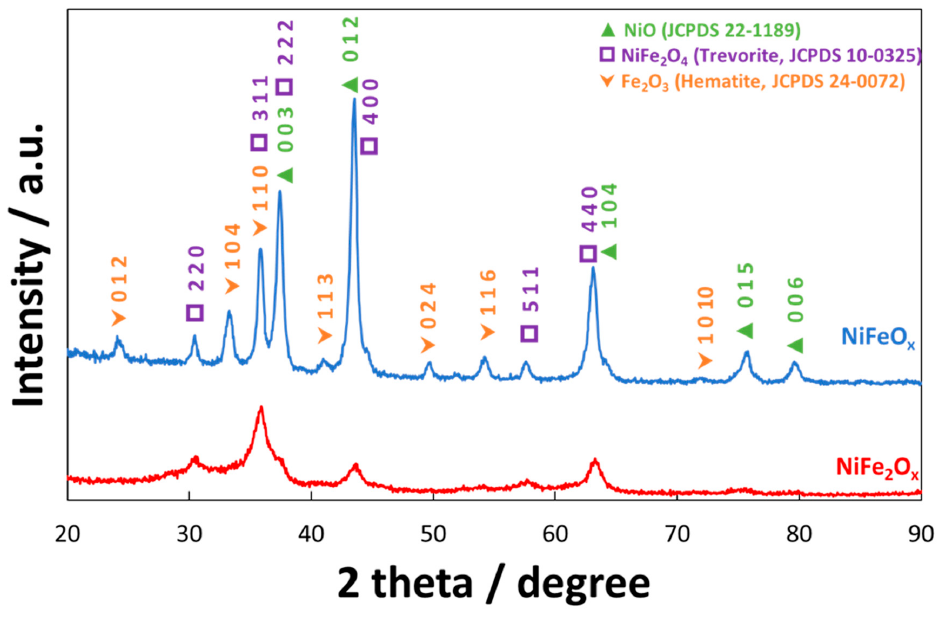
Figure 1. X-ray diffraction patterns of the NiFe 2 O x and NiFeO x catalysts calcined at 450°C. The catalyst formulations NiFe 2 O x and NiFeO x refer to a nominal atomic ratio Ni:Fe equal to 1:2 and 1:1, respectively.